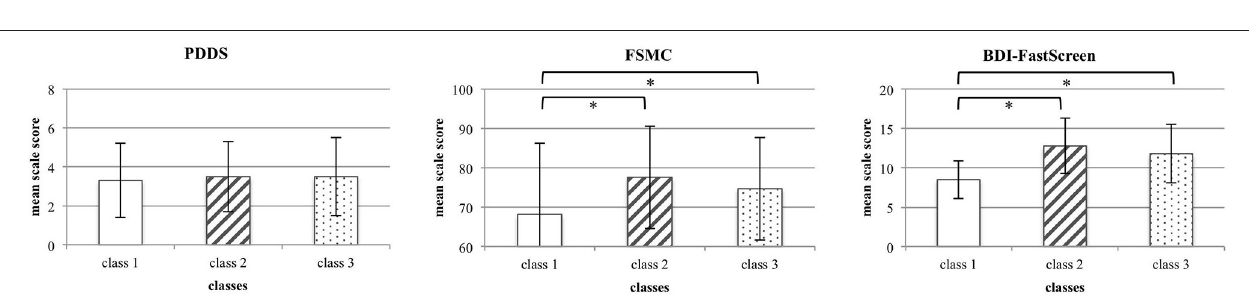
FIGURE 3 | Differences in disability, fatigue and depression symptoms between the three classes. For each measure, mean total scores ( ± SD) are displayed. Asterisks highlight statistically significant differences across